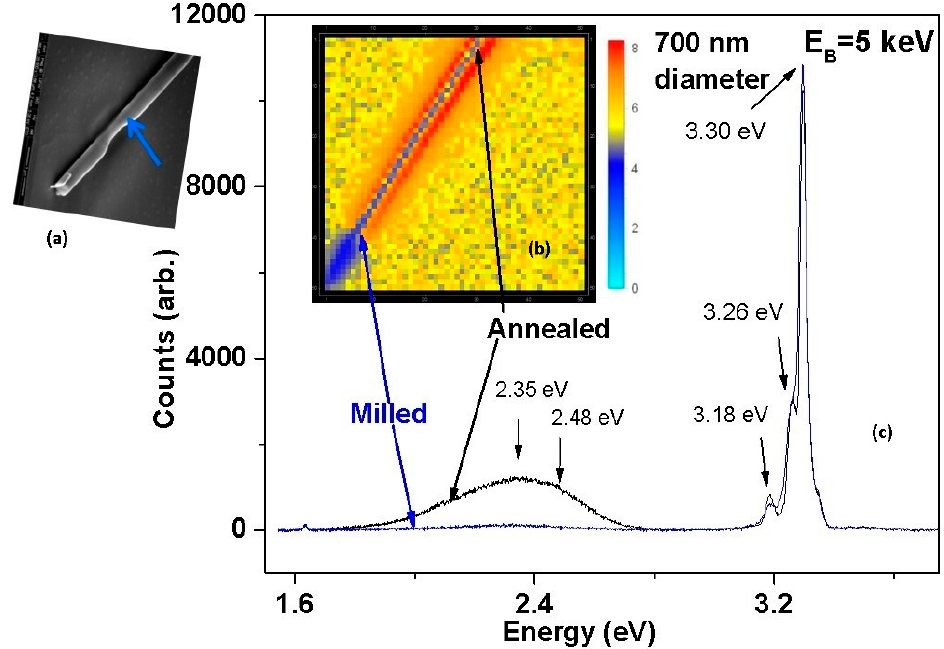
Figure 10. ( a ) SEI, ( b ) HSI, and ( c ) DRCL spectra obtained at E B = 5 keV of a 700 nm diameter ZnO nanowire on SiO 2 with a wire section milled down to 400 nm to remove segregated defects (lower left) versus a section e-beam annealed to promote additional defects (upper right). With permission from [18]. Copyright 2018 American Chemical Society.